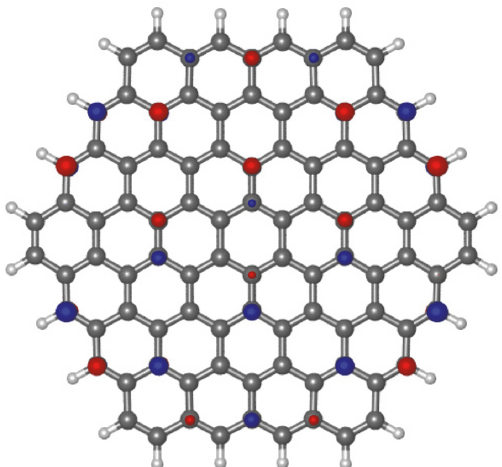
Figure 11: H 4 LUMO